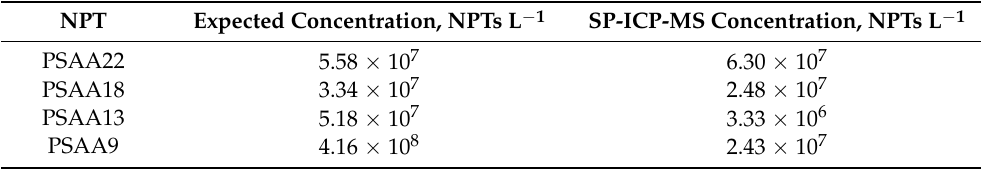
Figure 5. SP-ICP-MS time scan for the sample obtained for the mixture of PSAA22 and AuNPs@gel. Table 2. Expected nanoplastic number concentration and nanoplastics number concentration ob- tained by SP-ICP-MS for different nanoplastic model